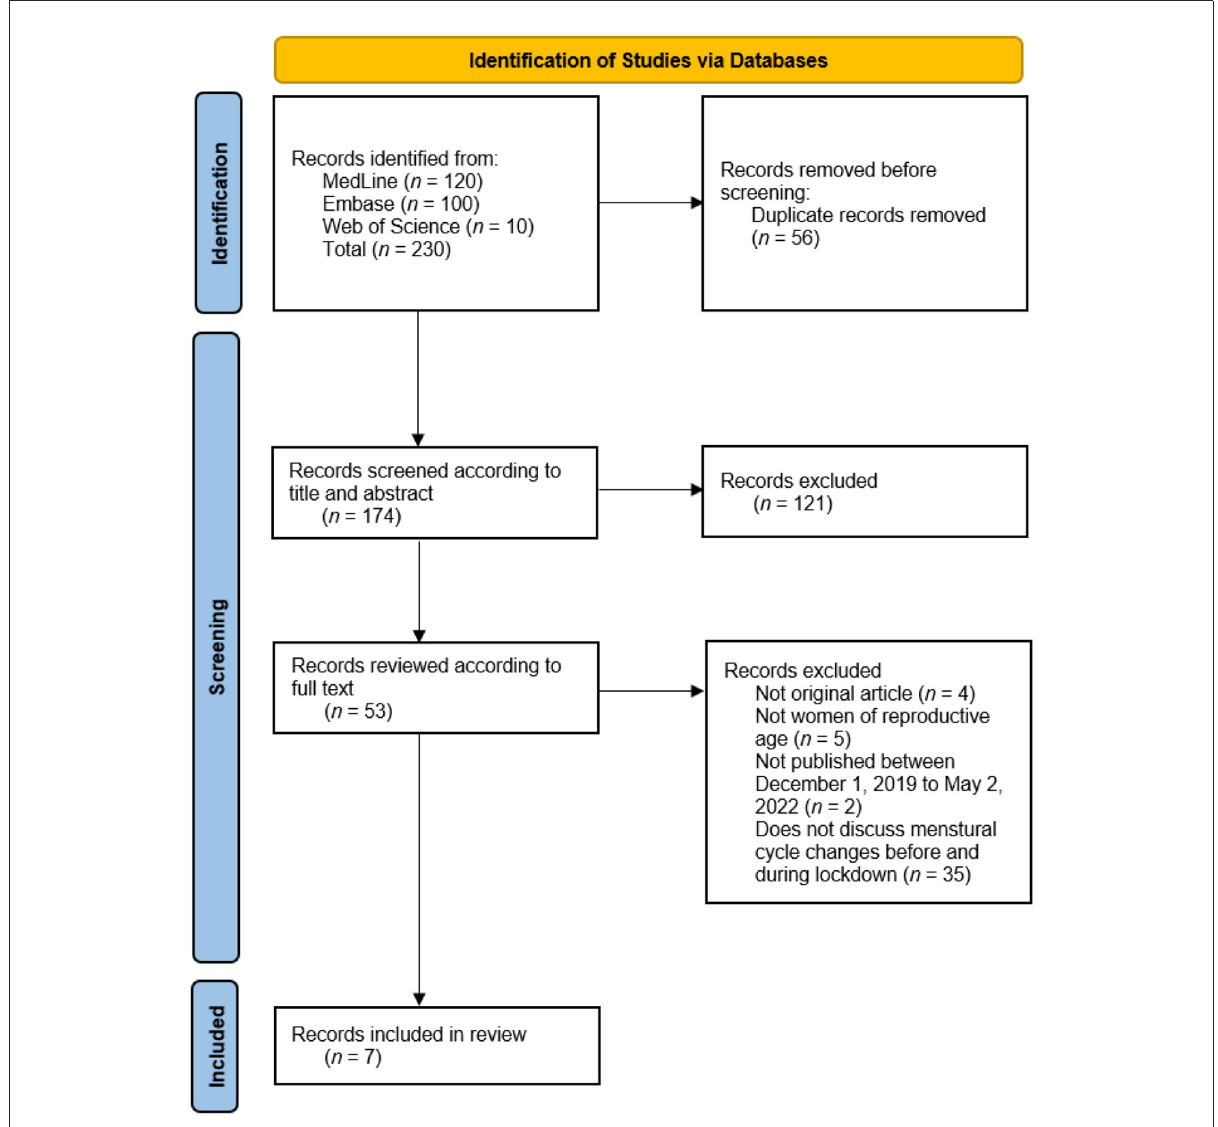
FIGURE1 PRISMA flow diagram for systematic